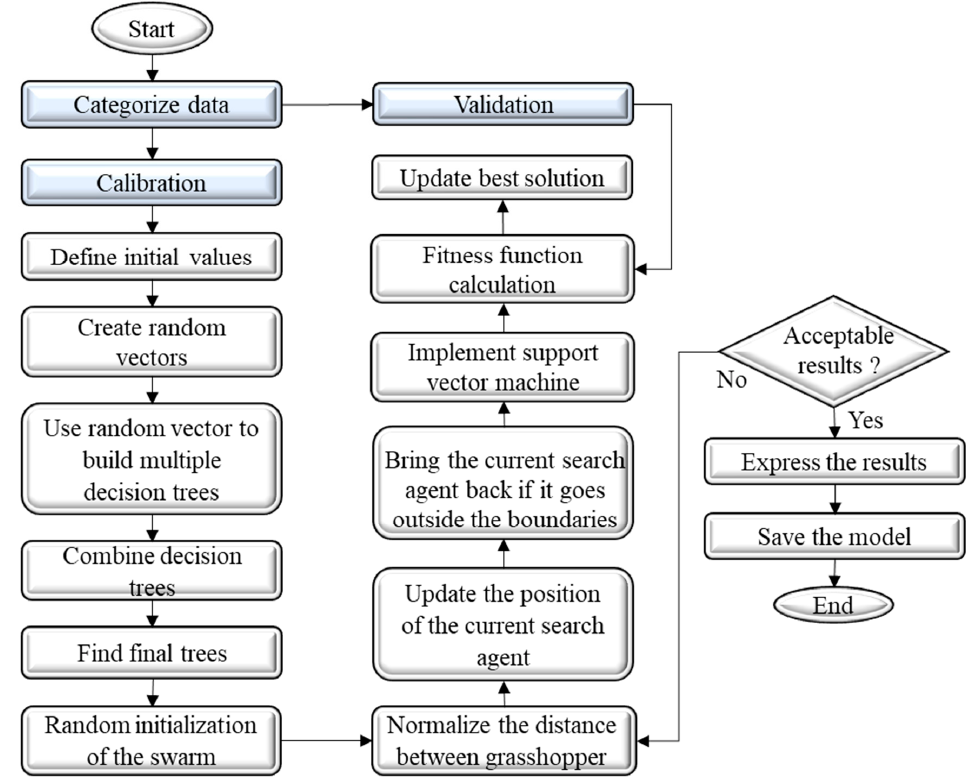
Figure 3. The flowchart of the developed hybrid technique for AIT forecasting.